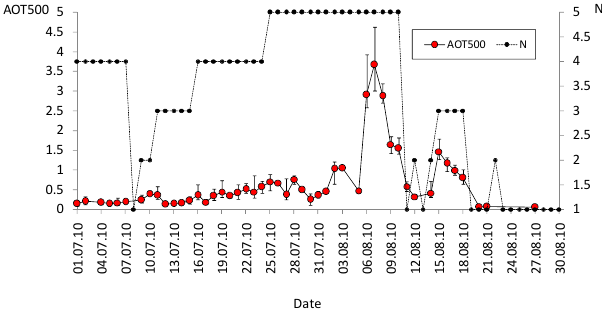
Fig. 2. Daily mean AOT500 (level 2) with error bar showing the Fig.2. Daily mean AOT500 (level 2) with error bar showing the variation range during the day (a) and Nesterov’s classes of flammability N (b). Moscow. variation range during the day (a) and Nesterov’s classes of flamma- bility N (b) . Meteorological Observatory of Moscow State Univer-